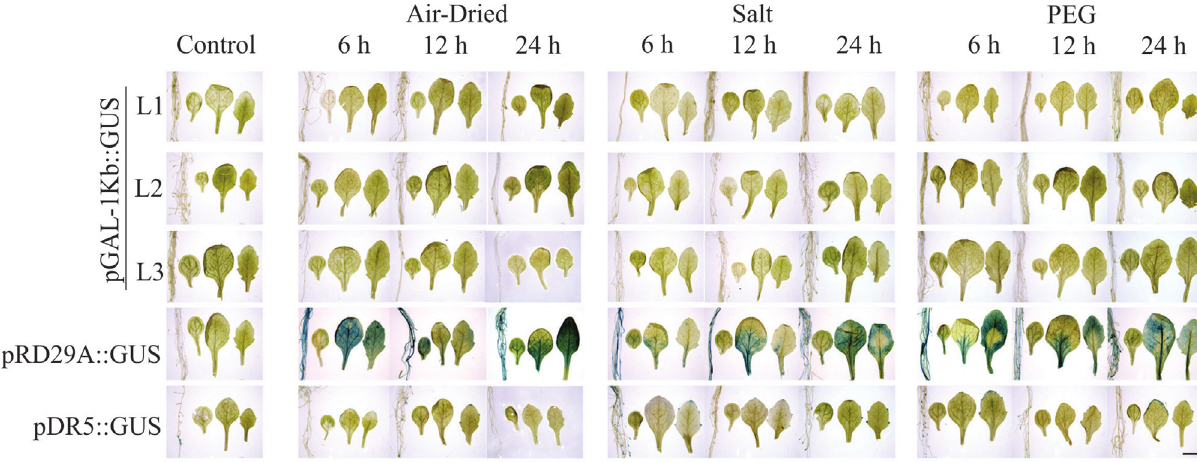
Figure 2 - pGAL-1kb::GUS histochemical assay. Three transgenic lineages, pGAL-1kb::GUS (L1, L2 and L3), pRD29::GUS positive control and pDR5::GUSnegativecontrol,weresubmittedtocontroland6,12and24hoftheair-dried,saltstressandPEGconditions.Theorderofthesamplephotos is as follows: root, cotyledonal leaf, young leaf and totally expanded leaf. The data shown are representative of three independent lines (n = 3). Scale bars = 2 mm.